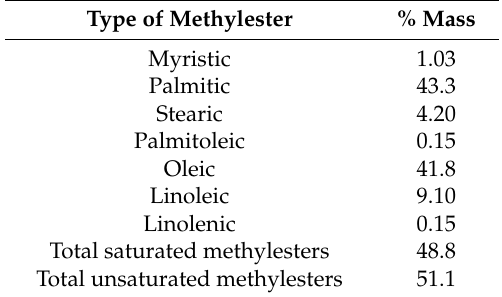
Table 1. Chemical composition of the used palm biodiesel (% mass).